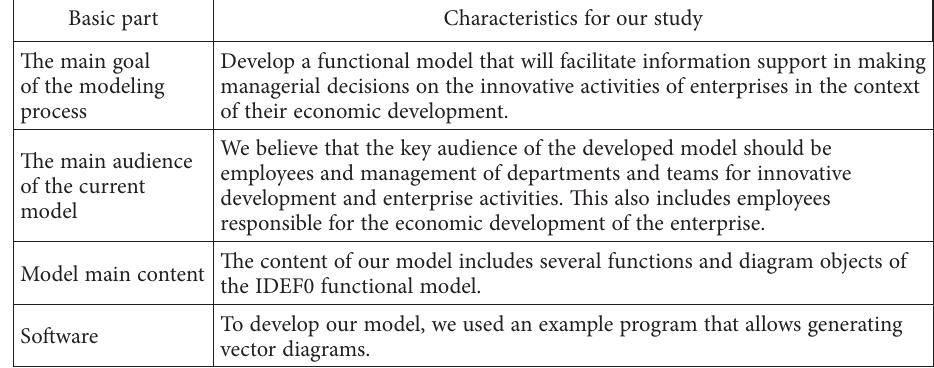
Table 1. Key basic parts for the formation of our model for the implementation of managerial decisions on the innovative activity of an enterprise in the context of economic development Basic part